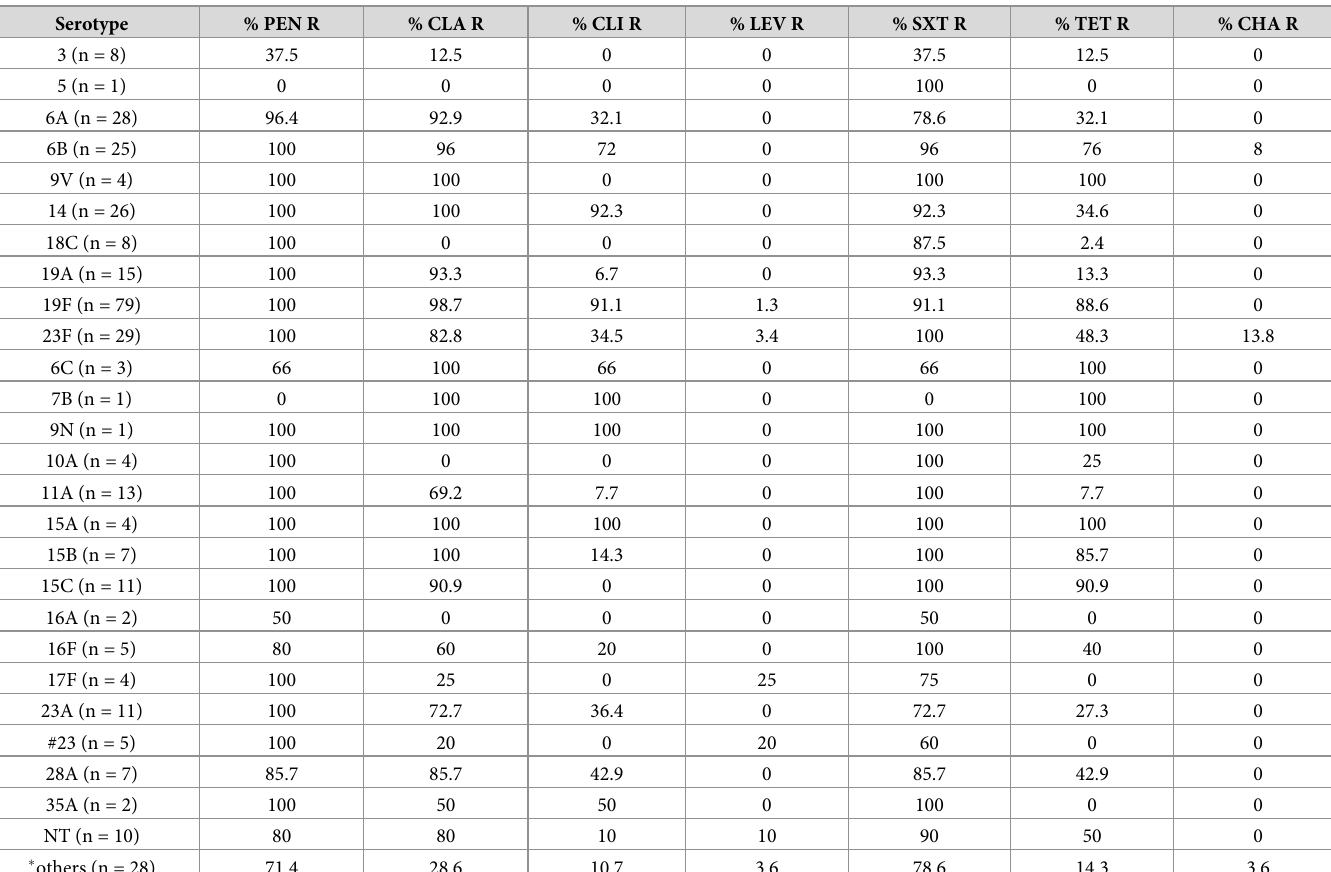
Table 5. Antibiotic resistance for the vaccine serotypes and non-vaccine serotypes in both cities from October 2017 to the end of March 2019.